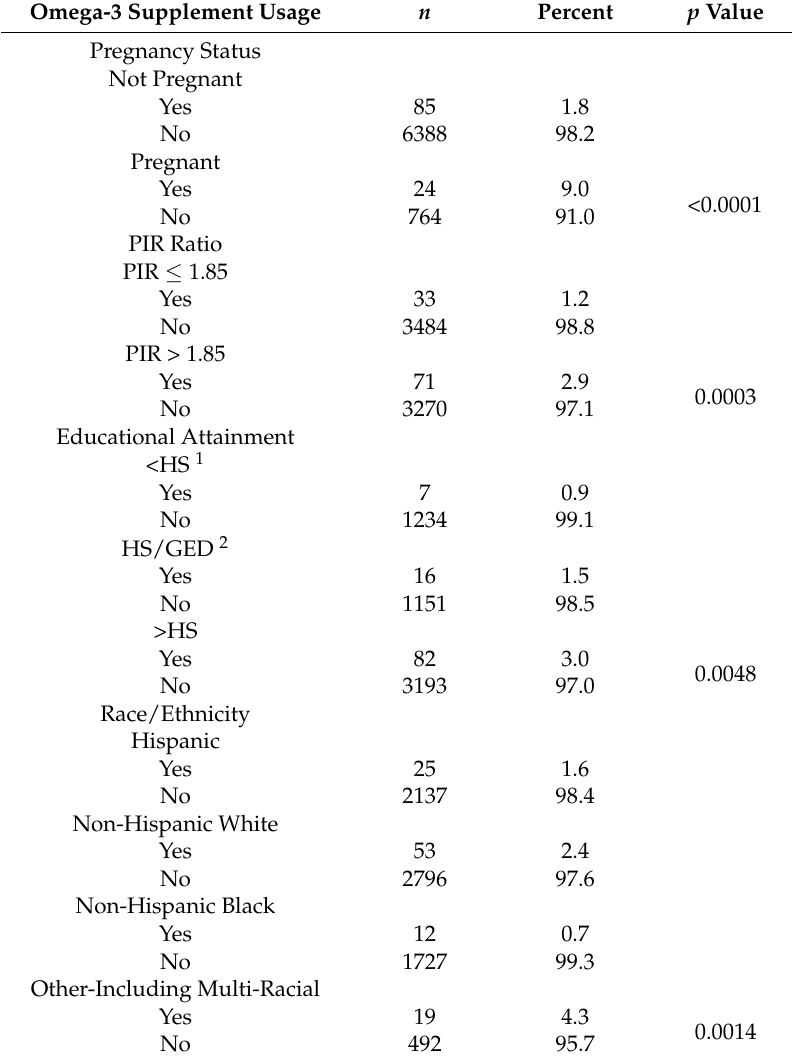
Table 6. Omega-3 fatty acid-containing supplement